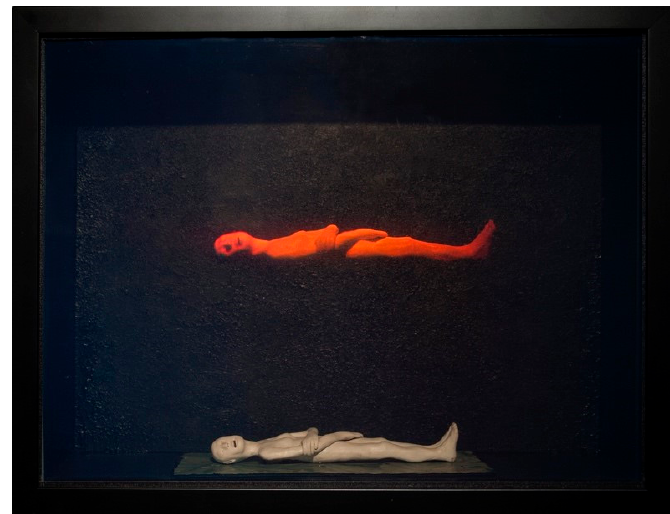
Figure 7. Body and Soul (2008). Reflection hologram, in box with model, 40 cm × 30 cm × 10 cm.